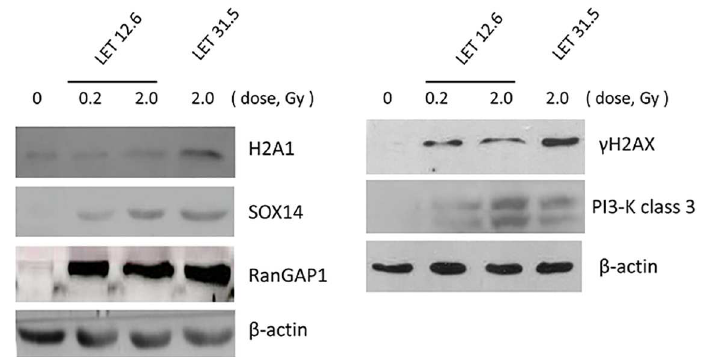
Fig 2. Analyses of proteins expression changes by immunoblotting hybridization. The altered expression levels of H2A1, SOX14, RanGAP1, γ H2AX, and PI3K-III were verified in the cells after irradiation with carbon ions at an LET value of 12.6 keV/ μ m or 31.5 keV/ μ m. The cell extracts for immunoblotting were preparedat 4 h after irradiation. β -actin expression was used as a sample loadingcontrol.